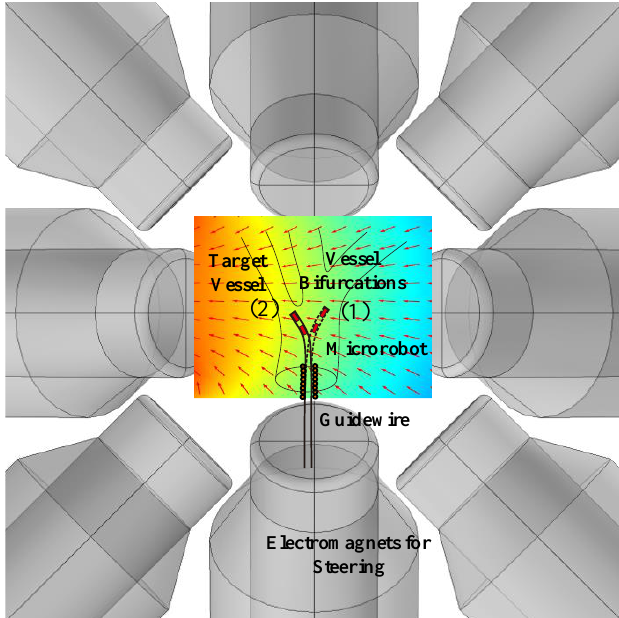
Figure 1. The schematic for flexible microrobot